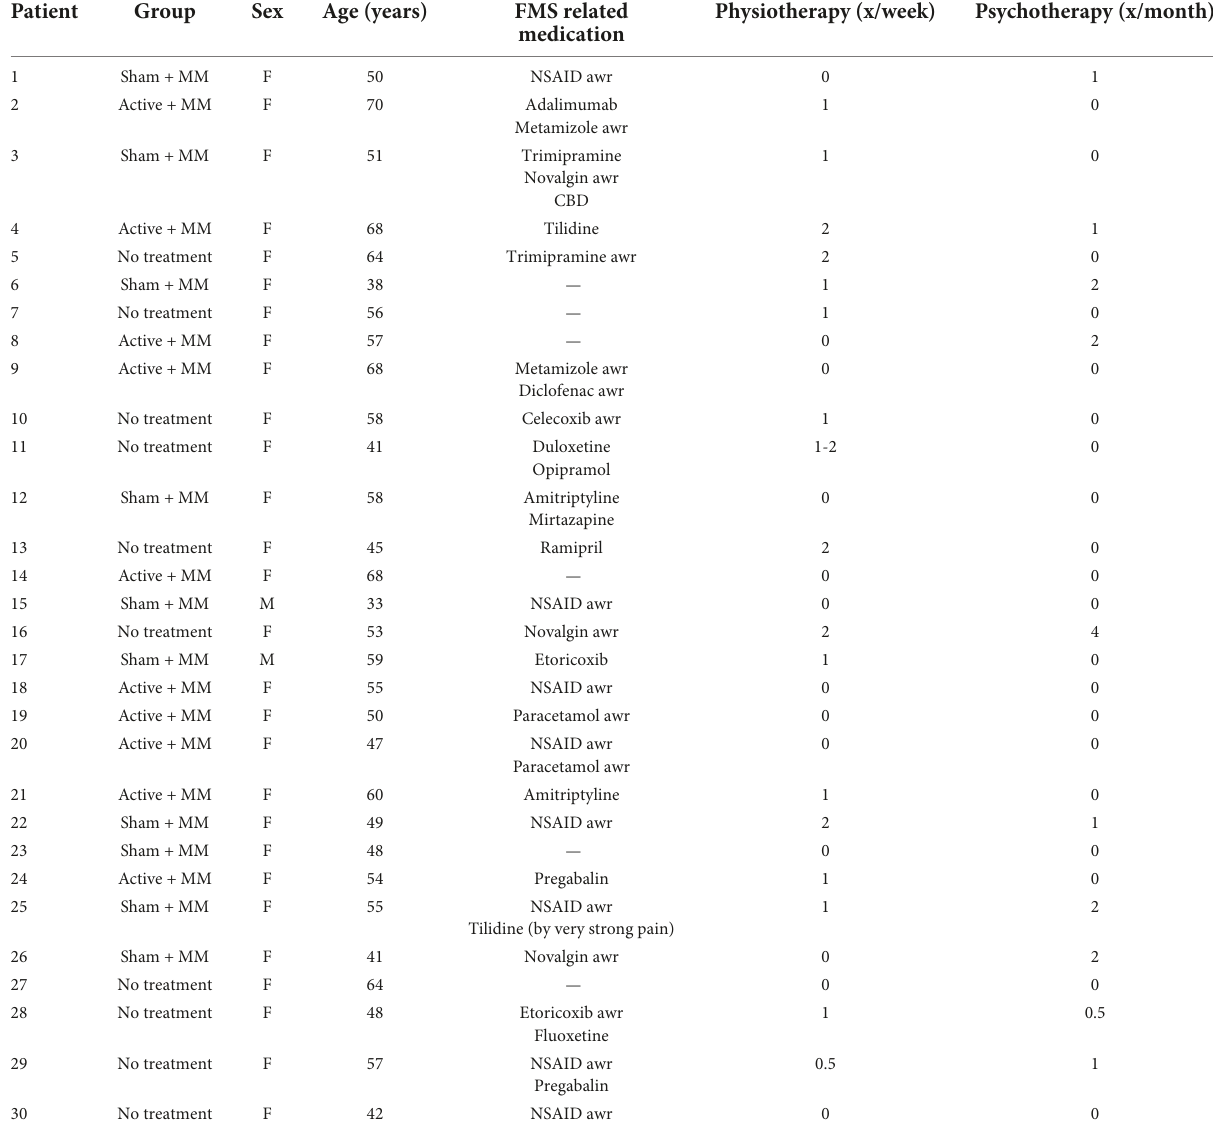
TABLE 2 Individual participant demographic and clinical